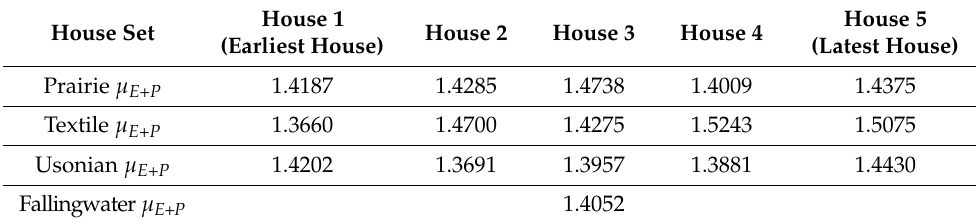
Figure 8. Linear trendline data for composite values of the stylistic periods (arrayed, from left to right, in order from earliest to latest in each style), compared with Fallingwater. Table 6. All houses, composite data, in chronological order.